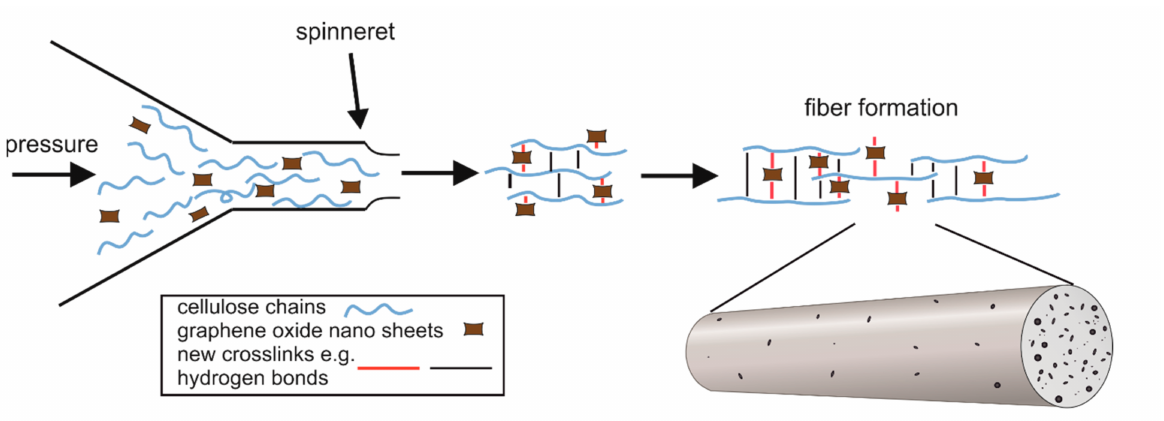
Figure 1. Diagram of the GO/CEL fibre forming process showing the distribution of GO particles in the cellulose